Question: Judging by this figure, is the value going up or going down?
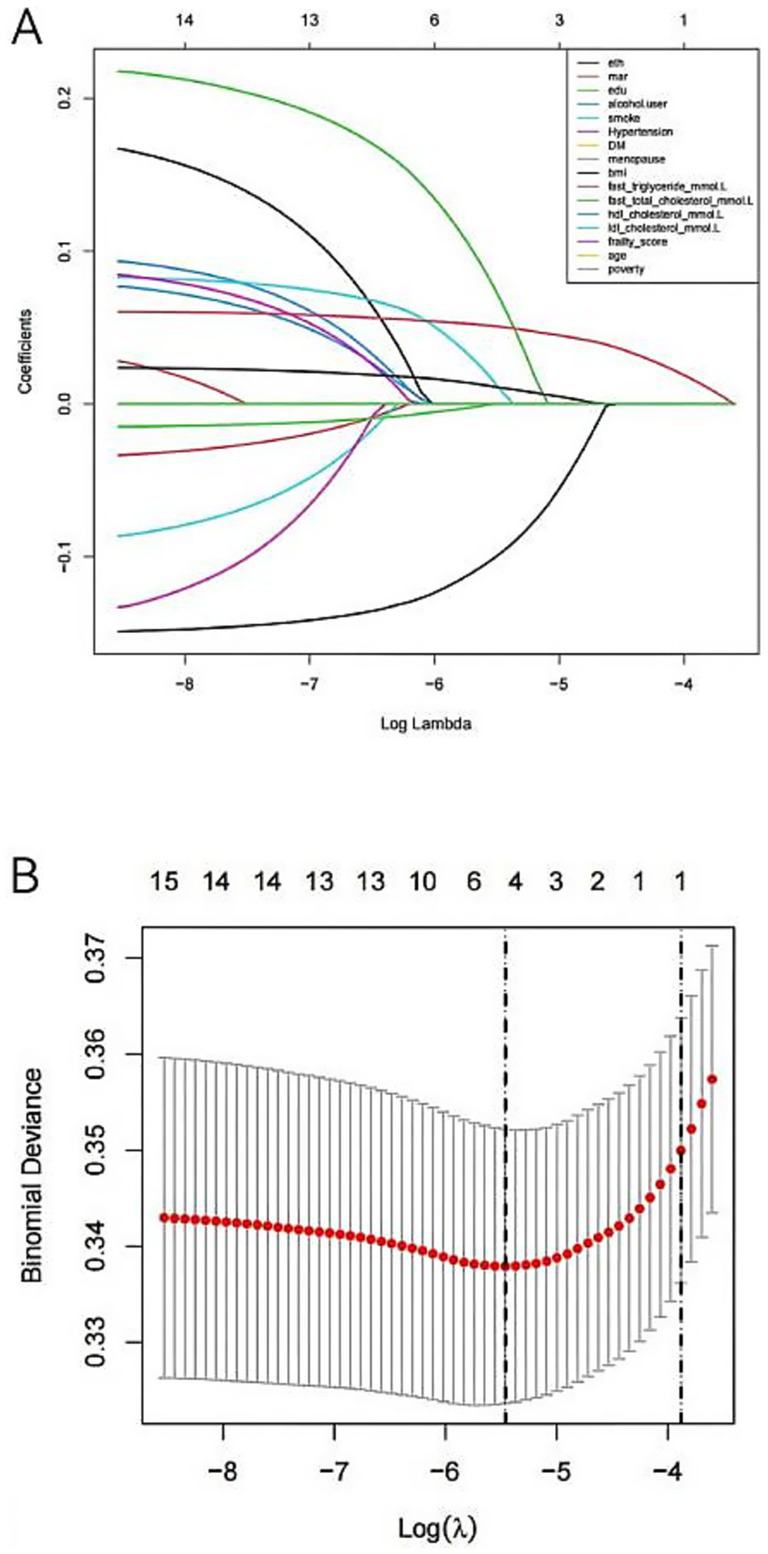
Answer: increasing